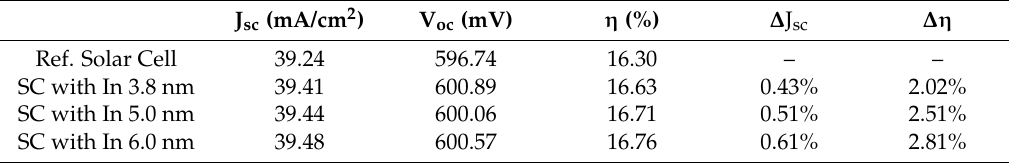
Figure 8. Photovoltaic J-V curves of reference solar cell (textured silicon but without NPs) and textured silicon solar cell coated with In NPs of various dimensions under normal incidence (θ = 0°). Table 1. Photovoltaic performances of textured silicon solar cells evaluated in this work